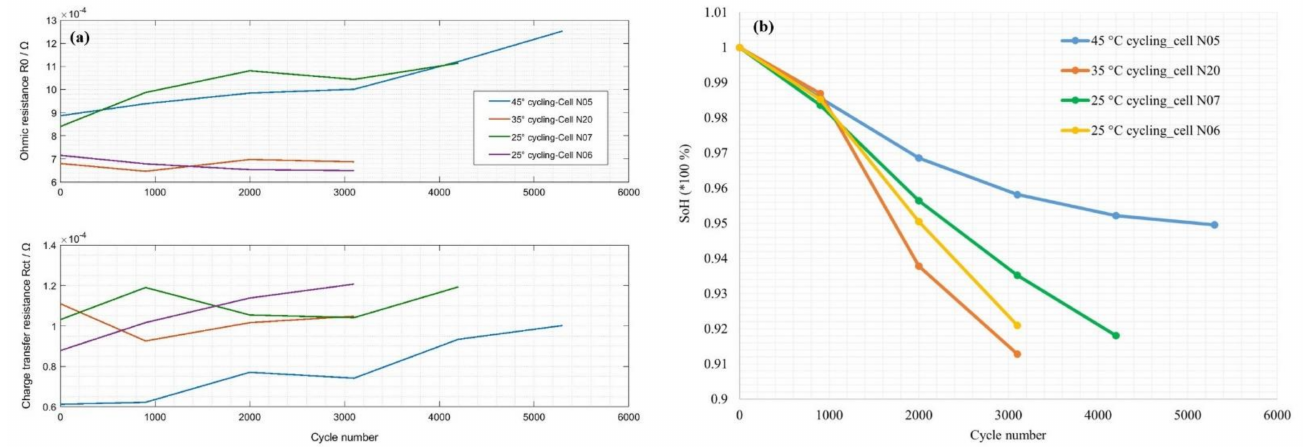
Figure 6. Cell degradation cycled at different temperatures; ( a ) impedance evolution, ( b ) capacity